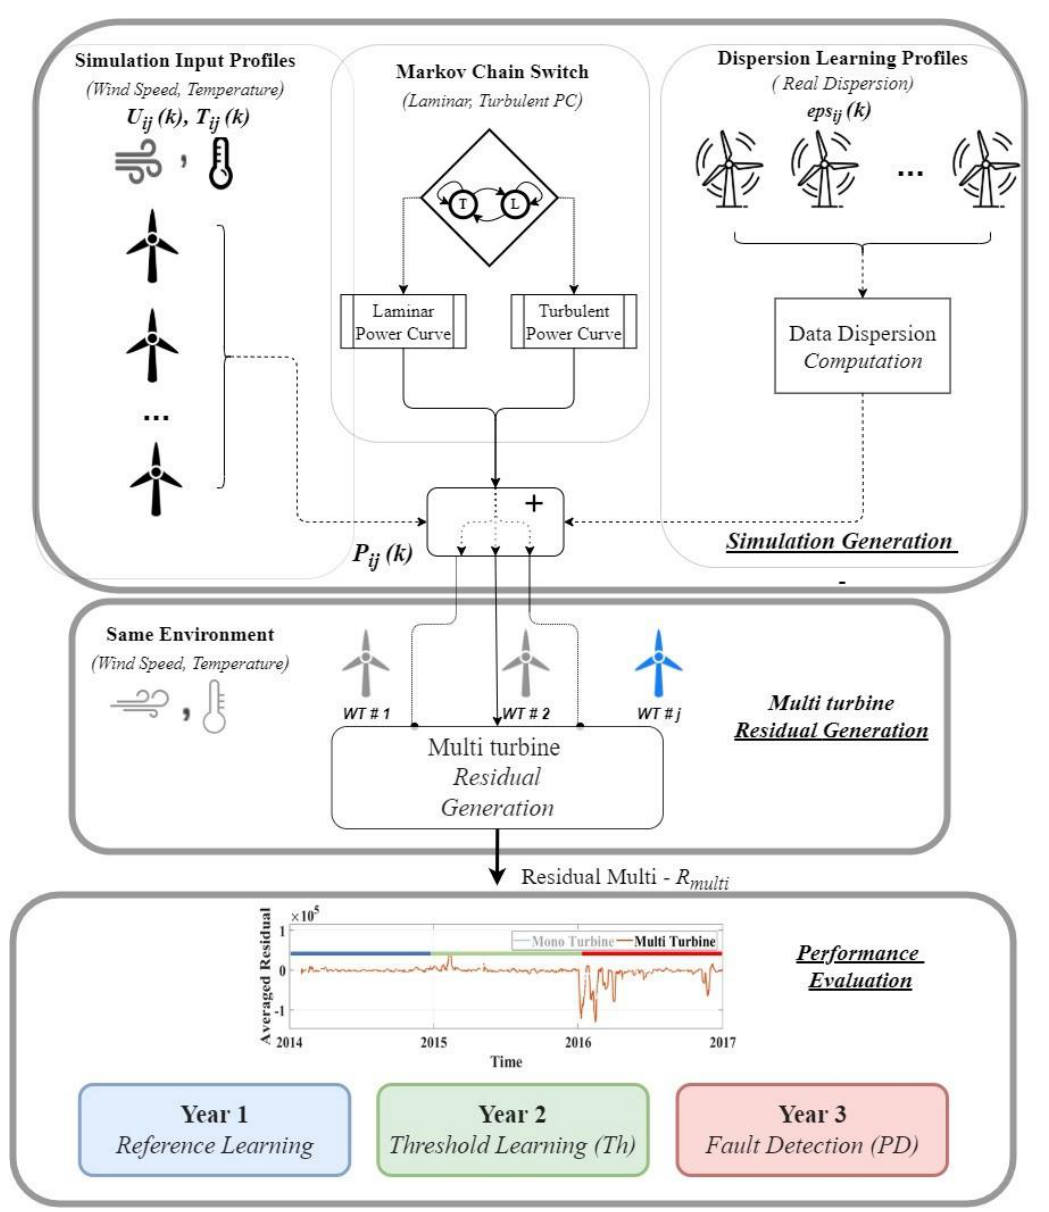
Figure 8. Multi-turbine simulation framework presenting the simulation generation and mono-tur- bine residual generation as step one; followed by multi-turbine residual generation and perfor- mance evaluation stages. mance evaluation